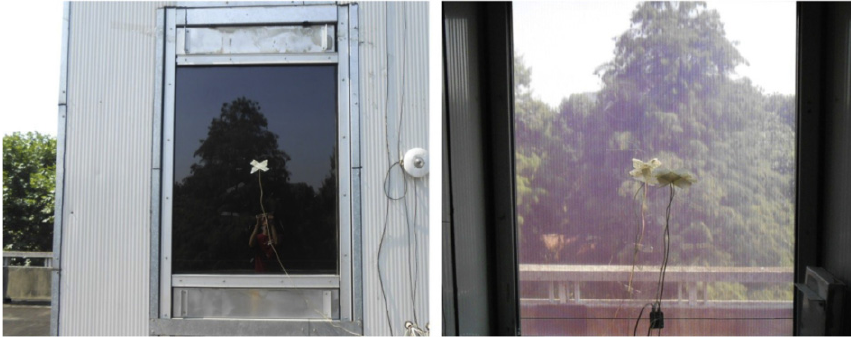
Figure 2. Semi-transparent a-Si PV glazing [11].